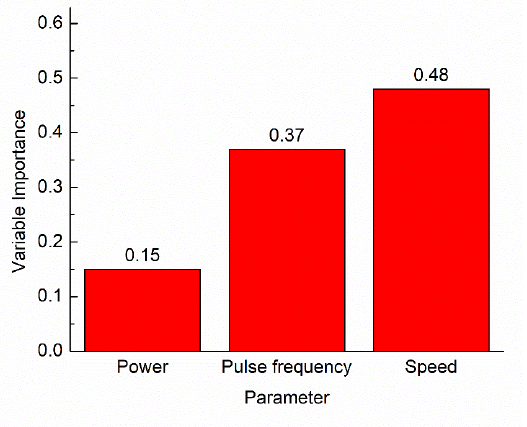
Figure 7. Average MAPE for various k values.